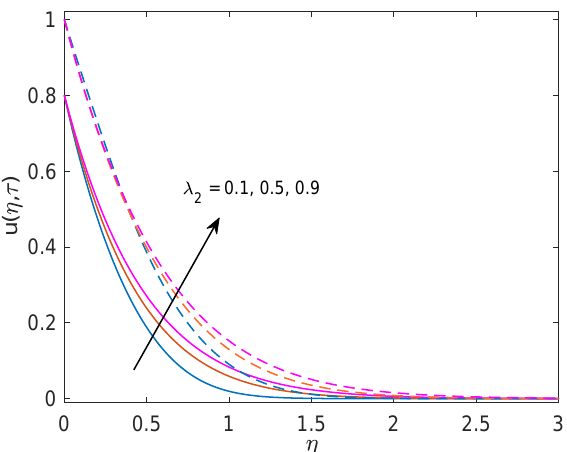
Figure 9. Effect of different values of λ 2 .